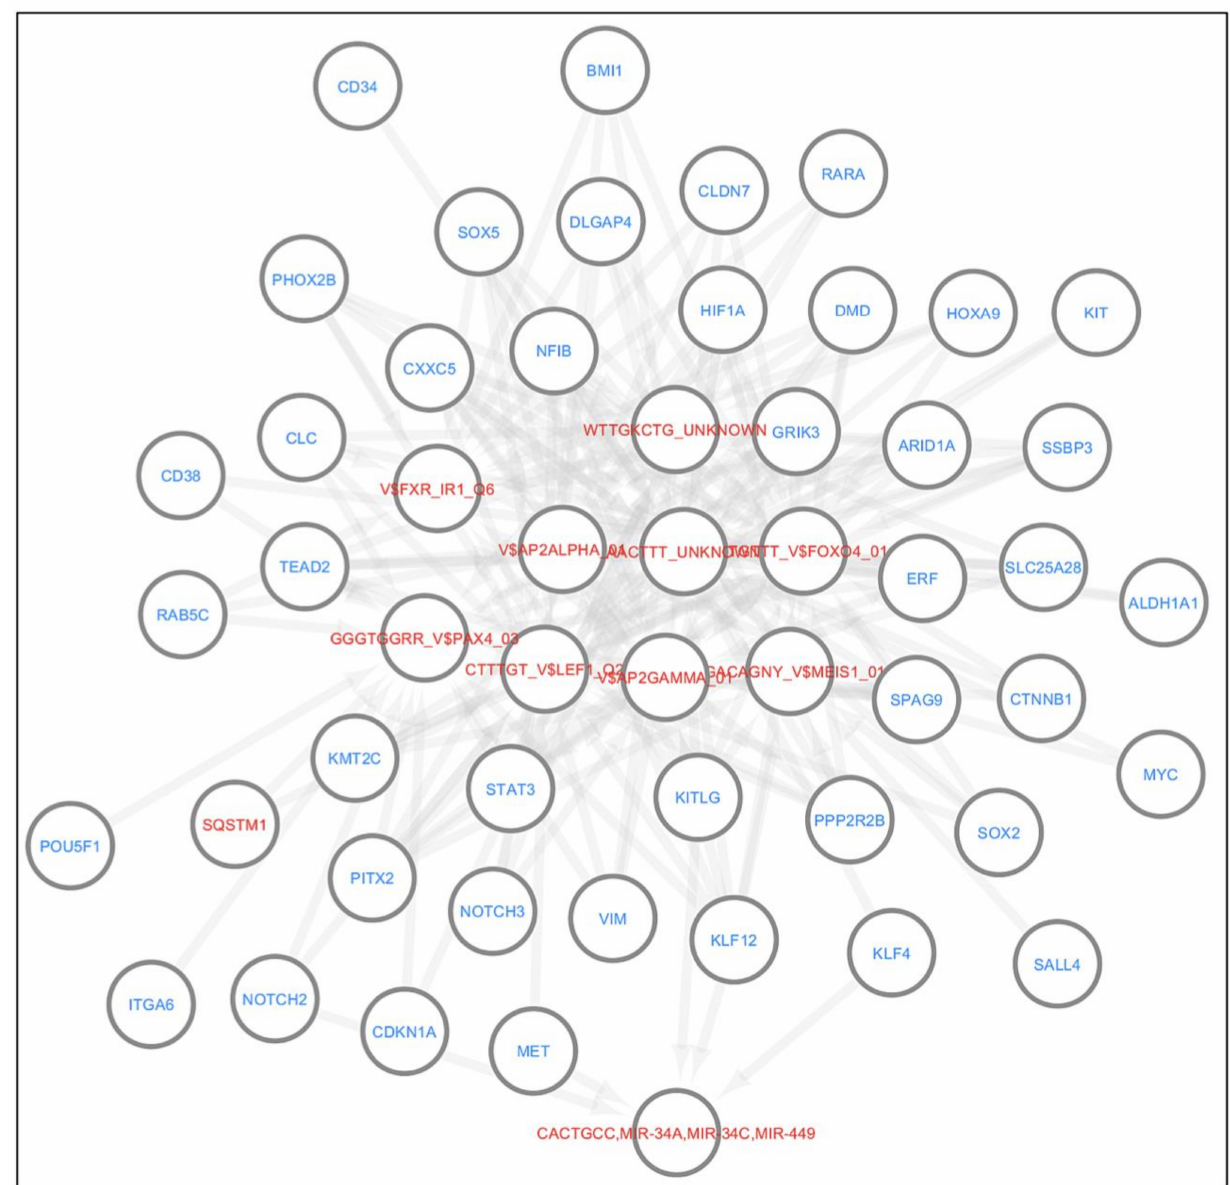
Figure 6. Genemania interrogation of transcription factor and miRNA targets. Transcription factor and miRNA target prediction from MSigDB using GeneMania. Targets are displayed in red, while genes are displayed in